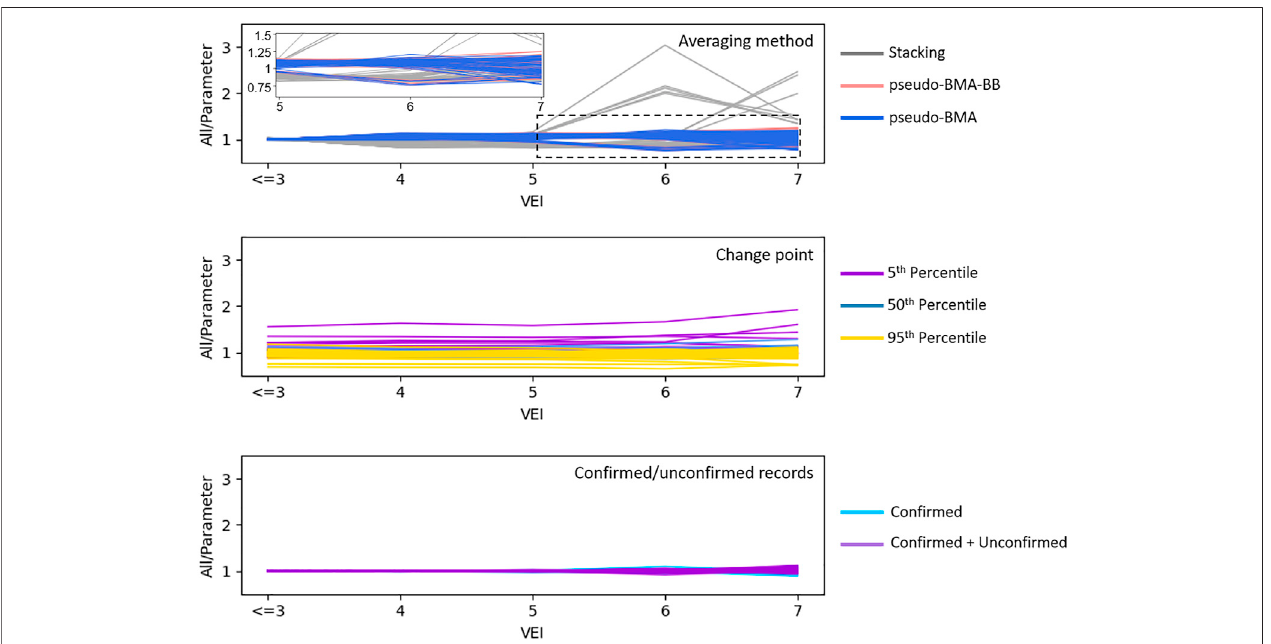
FIGURE13| Sensitivityoffrequency-magnitudeestimatesforvolcanoesthatundergoBayesianupdating.Thetopplotshowsthein fl uenceofthemodelaveraging method. Inset on the top plot is to show the change between VEI 6 and 7 where stacking produces relatively lower eruption probabilities compared to the BMA approaches. The middle plot shows the in fl uence of change point selection. The bottom plot shows the in fl uence of including only con fi rmed eruptions or adding uncon fi rmed eruptions into the eruption catalogue Values close to one indicate no or minor sensitivity, above one means the parameter is relatively lower than the average, and lower than one means the parameter is relatively higher probability than the